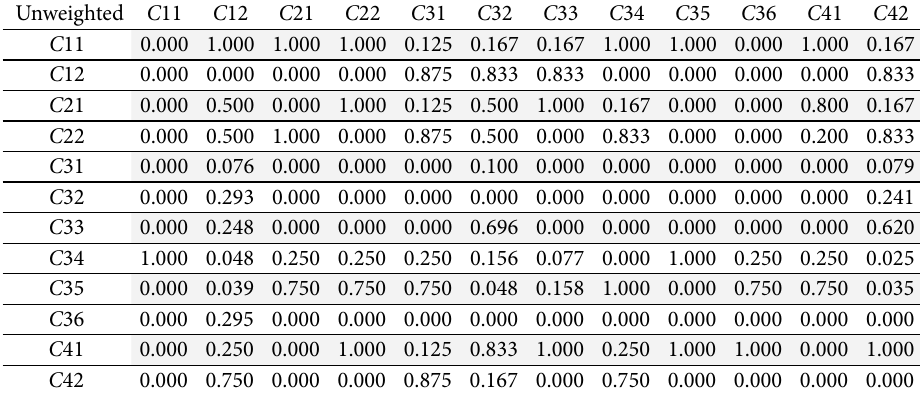
Table 7. Unweighted super-matrix